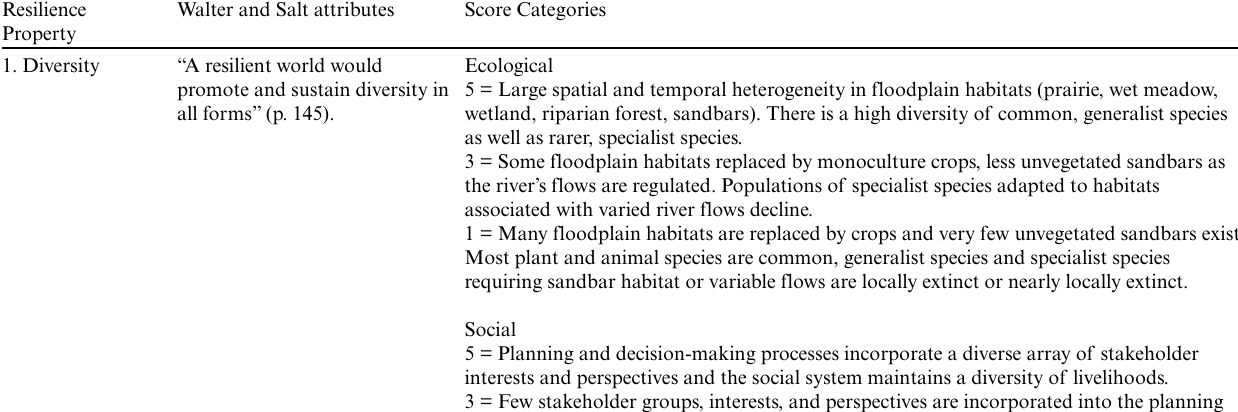
Table 1 . Scoring system used for assessing the resilience of the central Platte River social-ecological system with respect to resilience properties described by Walker and Salt (2006). The system may exhibit resilience with respect to a property (5), not be resilient with respect to a property (1), be in a neutral condition that is not clearly exhibiting resilience or lacking resilience (3), or exhibit a level of resilience intermediate between these scores (2 or